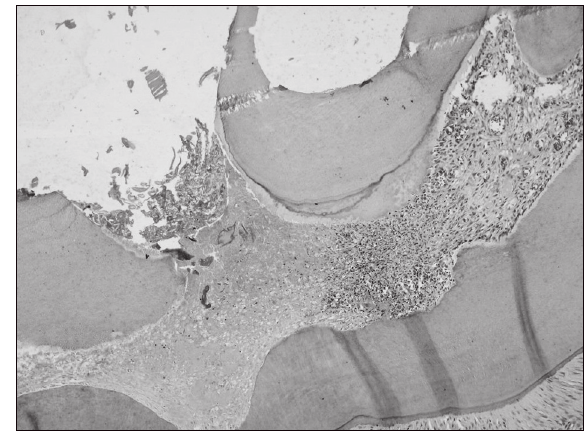
Figure 1 - Photomicrograph of a rat tooth 7 days after pulp- otomy and pulp capping with green propolis extract show- ing significant necrosis and mild inflammatory infiltrate (HE, 100 × ).